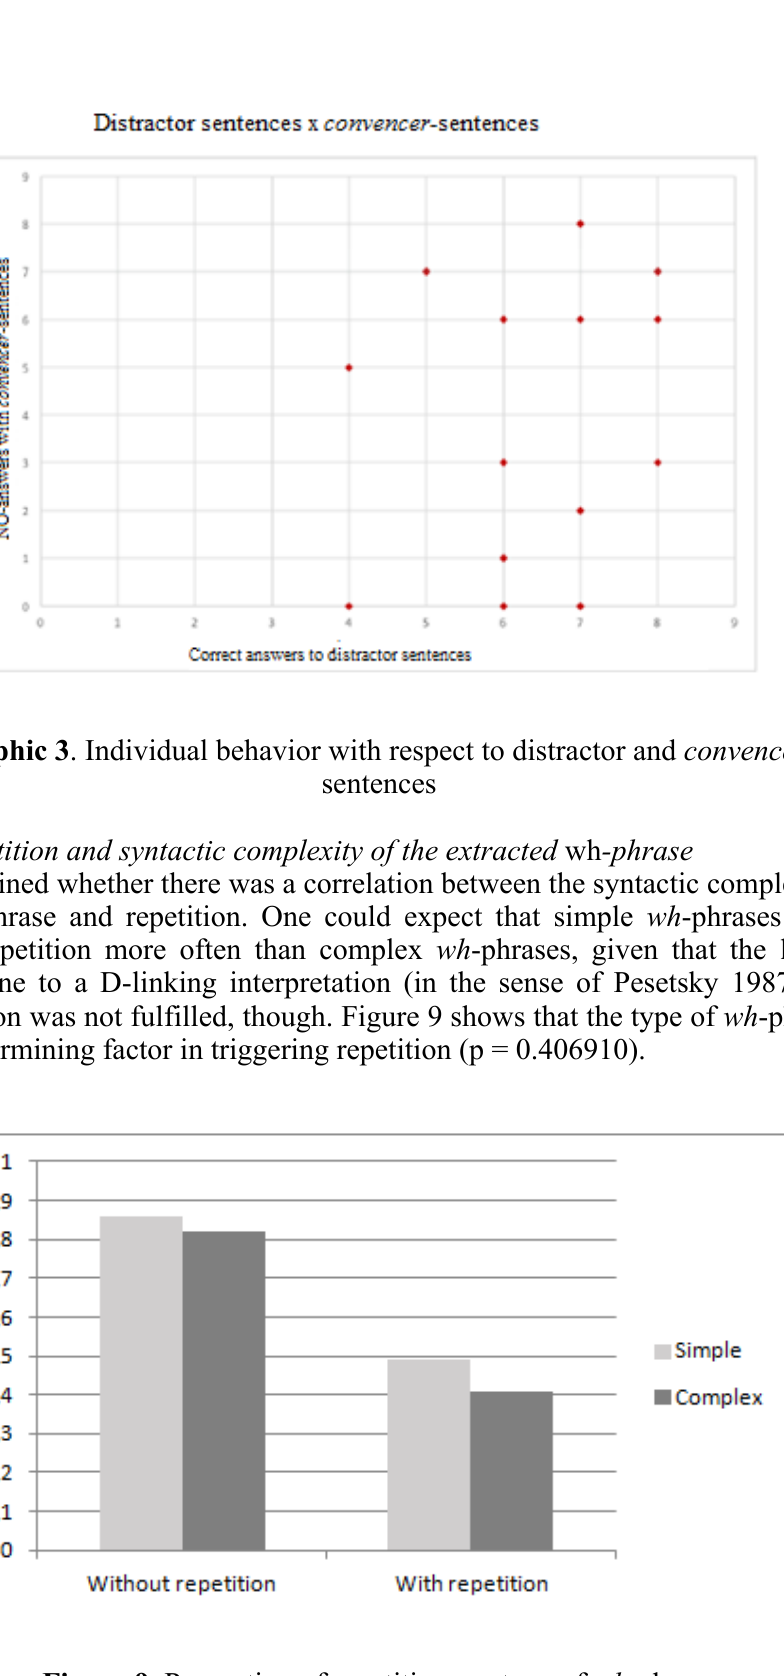
Figure 9 . Proportion of repetition per type of wh